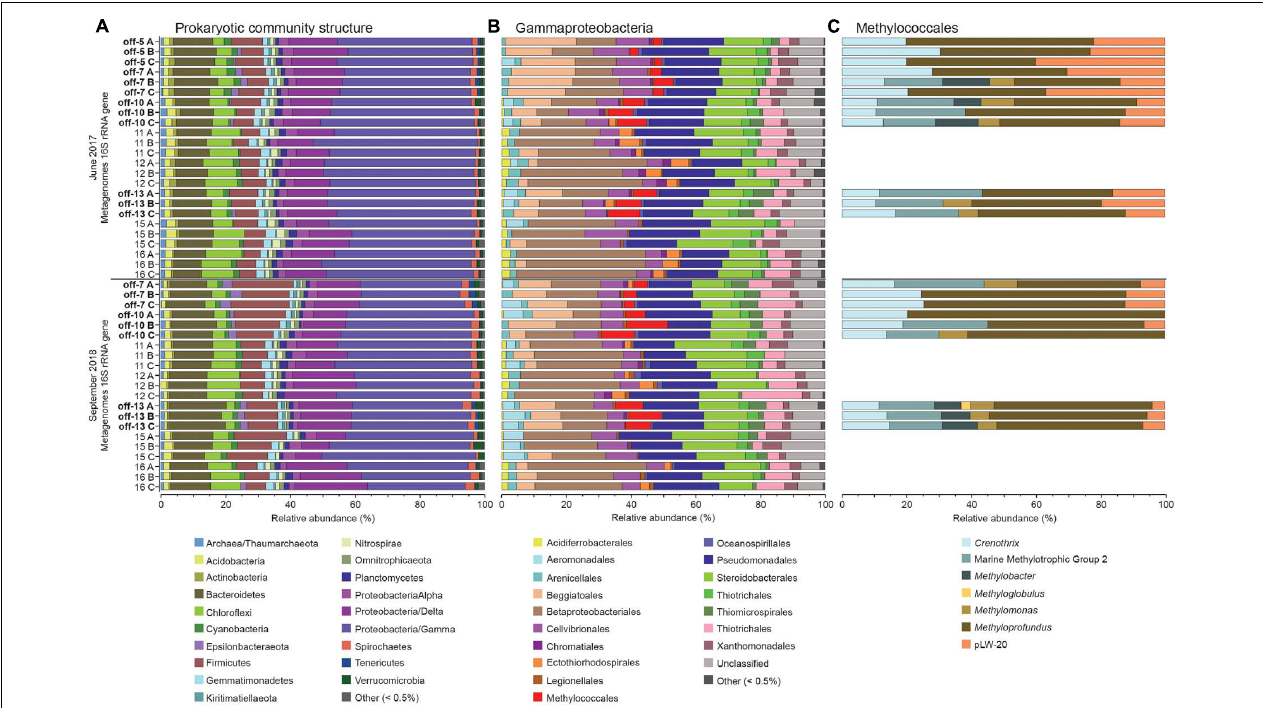
FIGURE 2 | The stacked bars show relative abundance ( x -axis%) of metagenome extracted 16S rRNA gene sequences: (A) prokaryotic phyla and Proteobacteria classes, (B) Gammaproteobacteria orders, and (C) Methylococcales genera (only detected in offshore stations). For (A,B) the dataset was delimited to taxonomic groups > 0.5% (average of all samples). The y -axis shows the sampling year, and station names and replicate samples indicated by letters A, B, and C. Offshore stations are indicated on the y -axis with the label